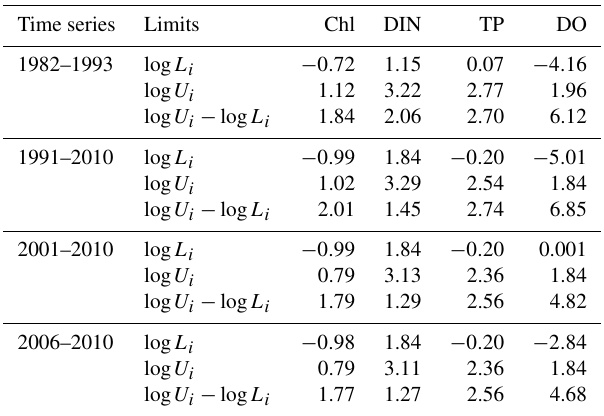
Table 2. Lower ( L i ), upper ( U i ), and difference (log U i − log L i ) logarithm value of the four state variables considered by the TRIX index. Values are extracted from the simulated data series reported in the first column.